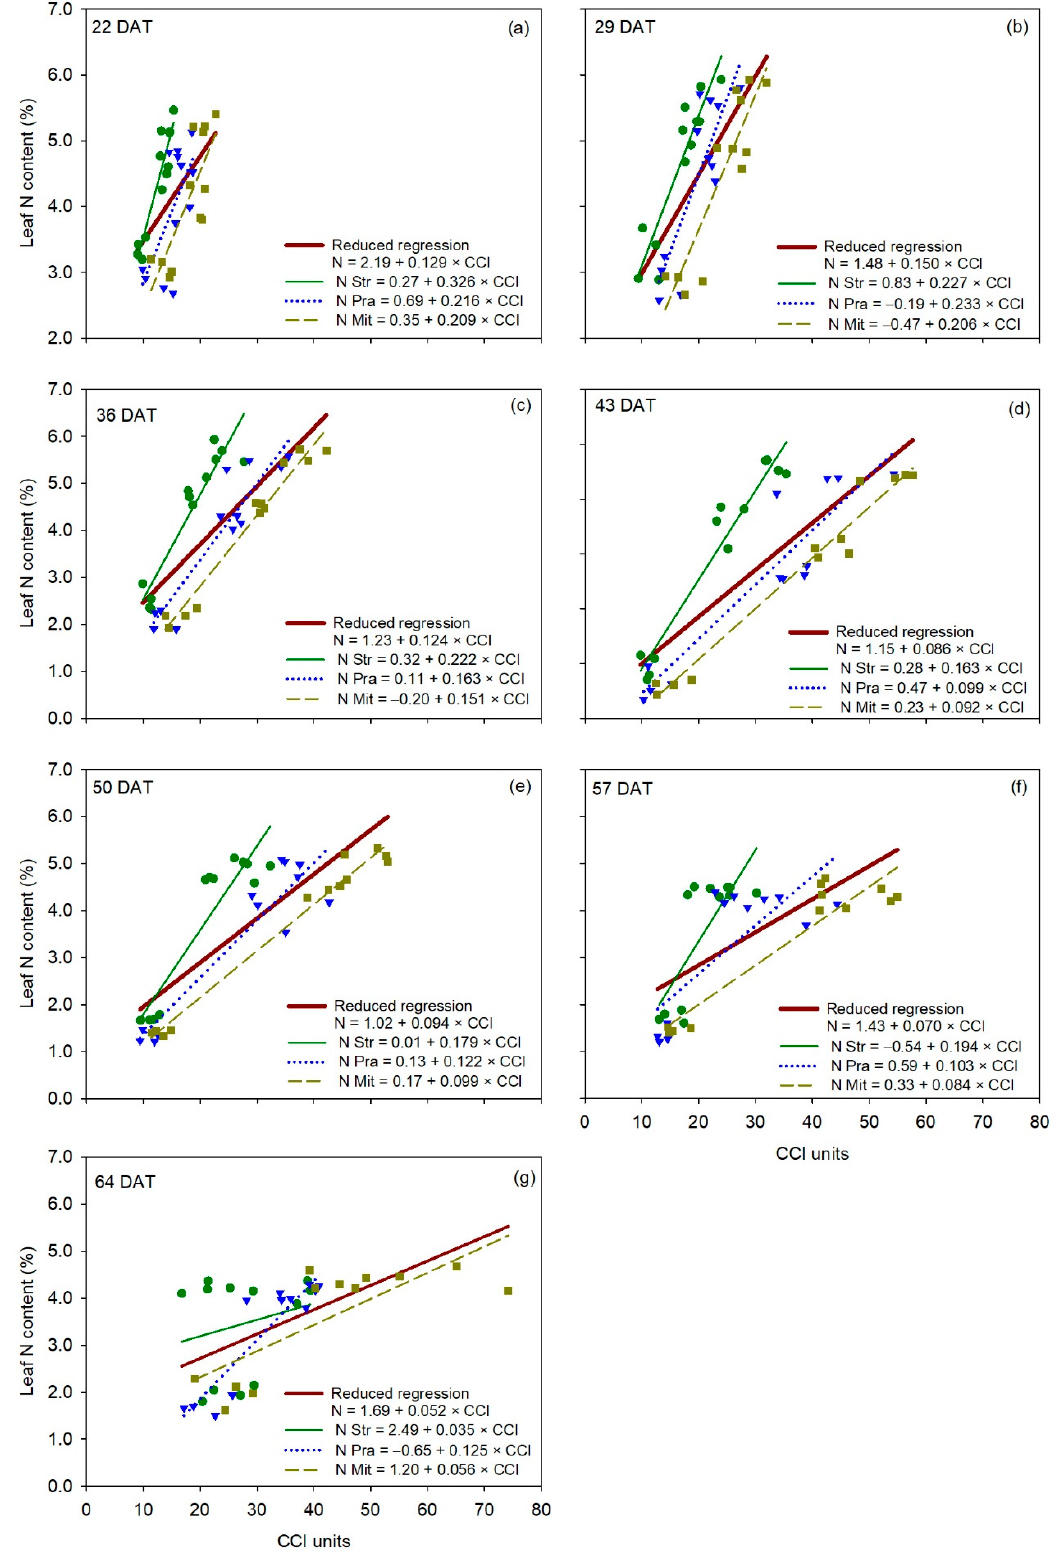
Figure 6. Linear regression between CCI measurements (independent variable) and leaf N content (dependent variable) for each cultivar of cucumber ( Cucumis sativus L.), for each measurement date (panels a – g ). The reduced regression is a regression with data of all three cultivars together. DAT is days after transplanting. Str, ‘Strategos’, Pra, ‘Pradera’, Mit, ‘Mitre’.